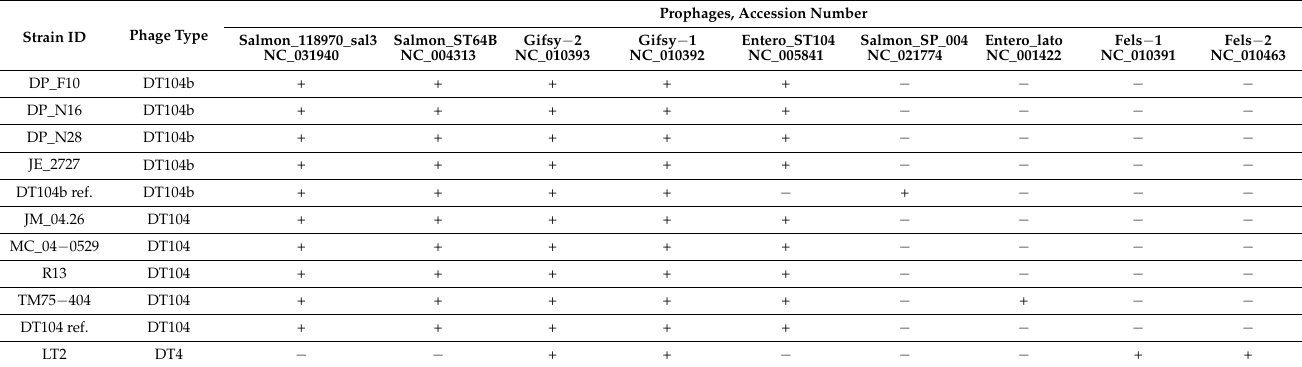
Table 4. List of confirmed prophages in S. Typhimurium strains. +, present; − absent. StrainID